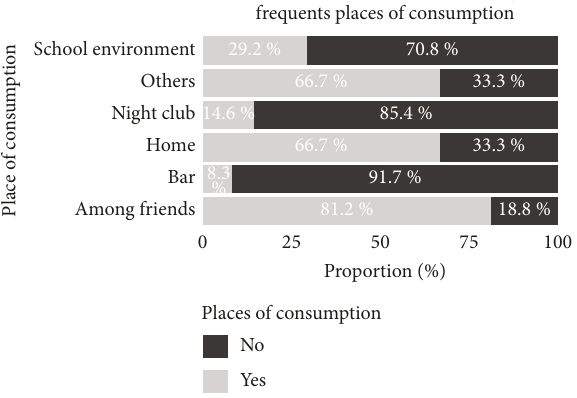
Figure 7: Distribution of the patients according to the place of frequent consumption.